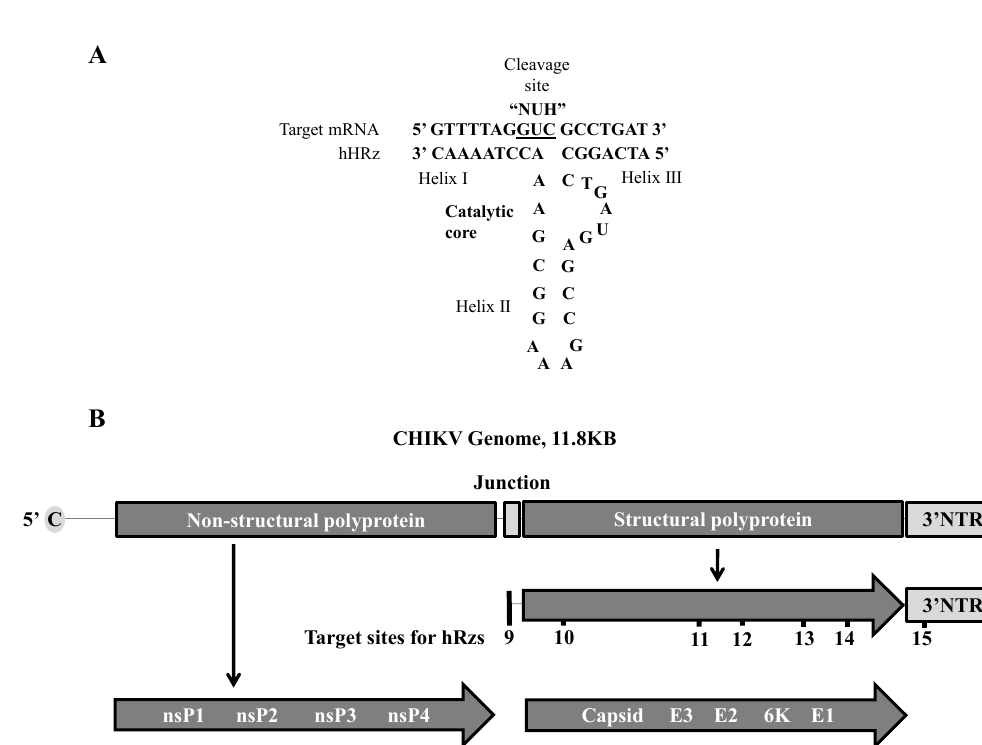
Figure 1. Generalized structure of a minimal hammerhead ribozyme (hRz) and organization of the chikungunya virus (CHIKV) viral genome showing hRz target sites. ( A ) hRzs consist of helix I and III which mediate complementary base-pairing with the target, and helix II which acts as the catalytic core mediating cleavage of the target RNA; ( B ) Schematic of the CHIKV genome. nsP1–nsP4 = polyprotein encoded by the genomic RNA. Capsid, E3, E2, 6K and E1 = polyprotein encoded by the sub-genomic RNA. 9-­‐‑15 = target sites for hRz#9-­‐‑#15.